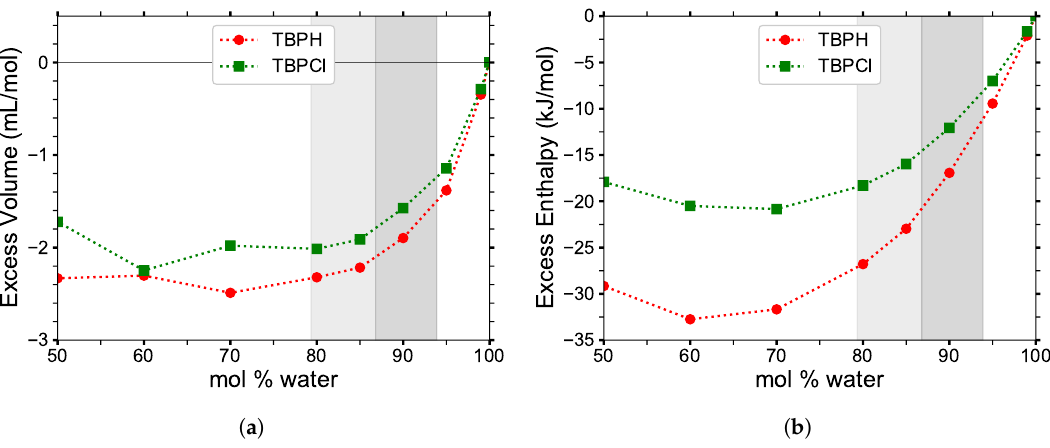
Figure 13. ( a ) Excess molar volume and ( b ) excess molar enthalpy of mixing of TBPH and TBPCl as a function of water concentration at p = 1atm and T =